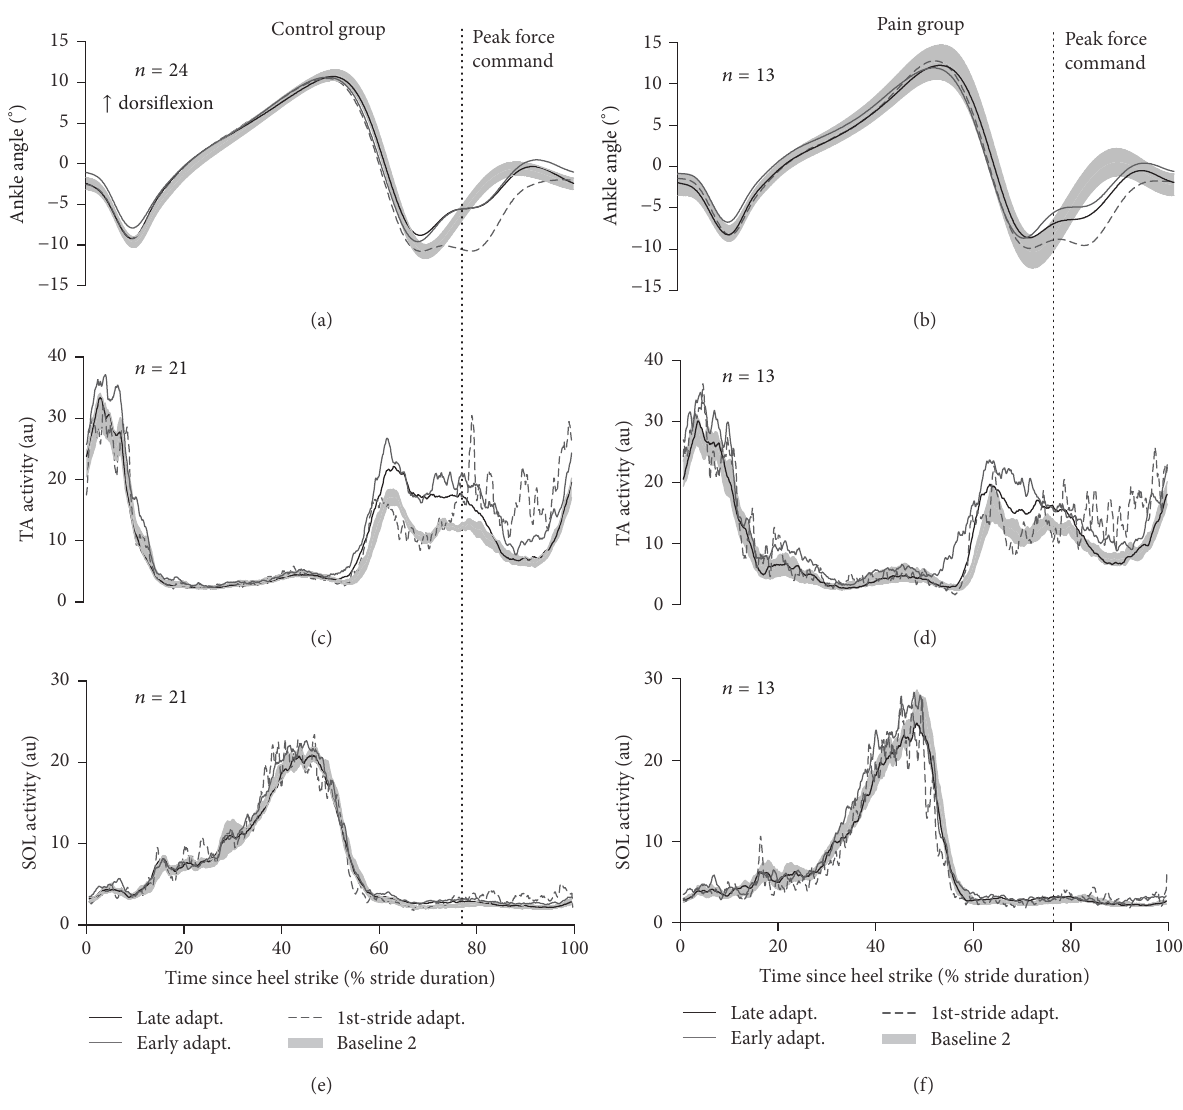
Figure 2: Summary of the results of the acquisition of motor skill (Day 1): (a), (c), and (e) show Control group averaged ankle angle (a), TA activity (c), and SOL activity (e) signals. (b), (d), and (f) present the same signals for the Pain group. The vertical dotted lines indicate the timing of the peak force command during the adaptation period. The shaded gray areas present each group baseline data (mean ± SEM). The gray lines illustrate the first stride (dashed line) and strides 2 to 11 (early adaptation; full line) of the adaptation period while the black line presents data during late adaptation (strides 151 to